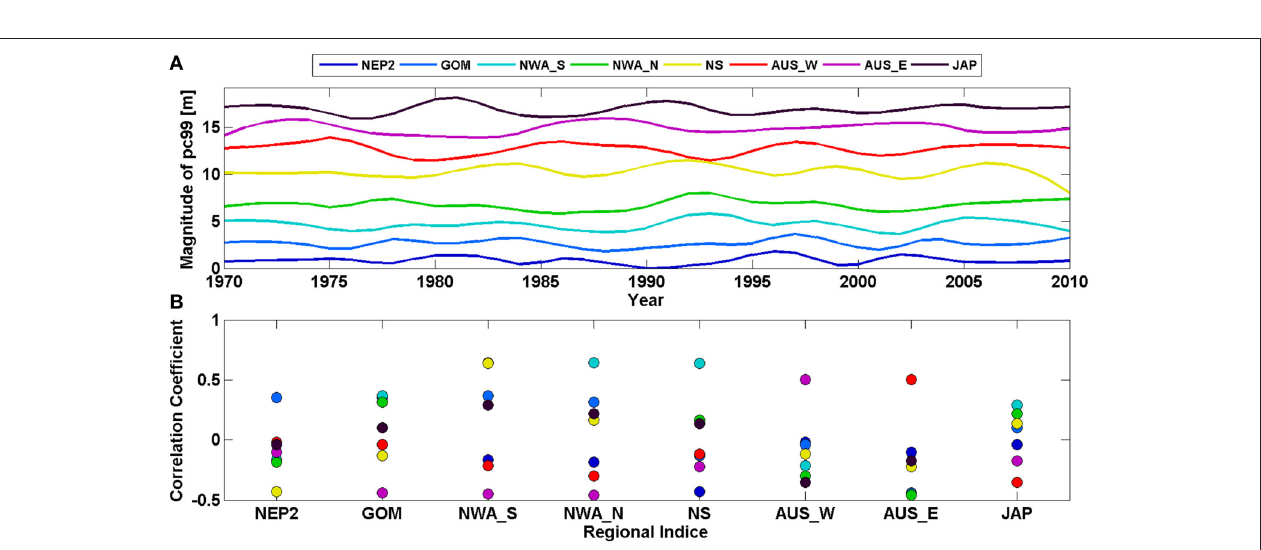
peaks in the Gulf of Mexico by approximately 1 year.